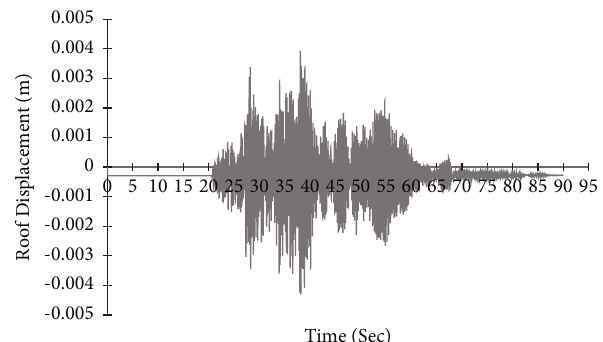
Figure 29: Displacement histories of the steel-HSS braced portal frame.